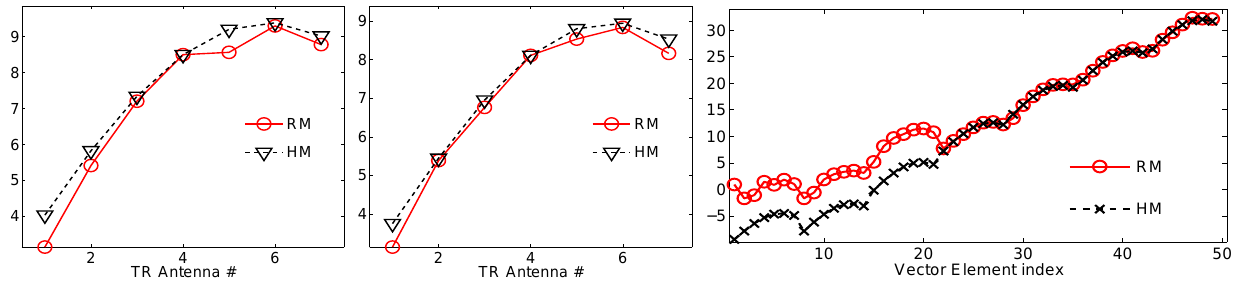
Figure 8. Phase distribution of the most significant TD-DORT eigenvector obtained at the central frequency (left) and those of the left singular vectors of the individual (middle) and full (right)